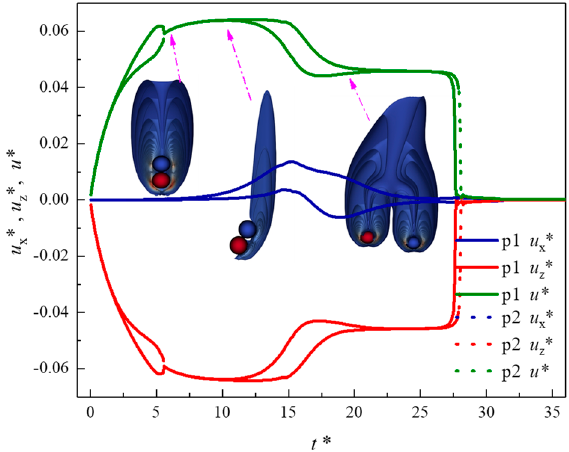
Figure 6. Velocity variation of two interacting particles.